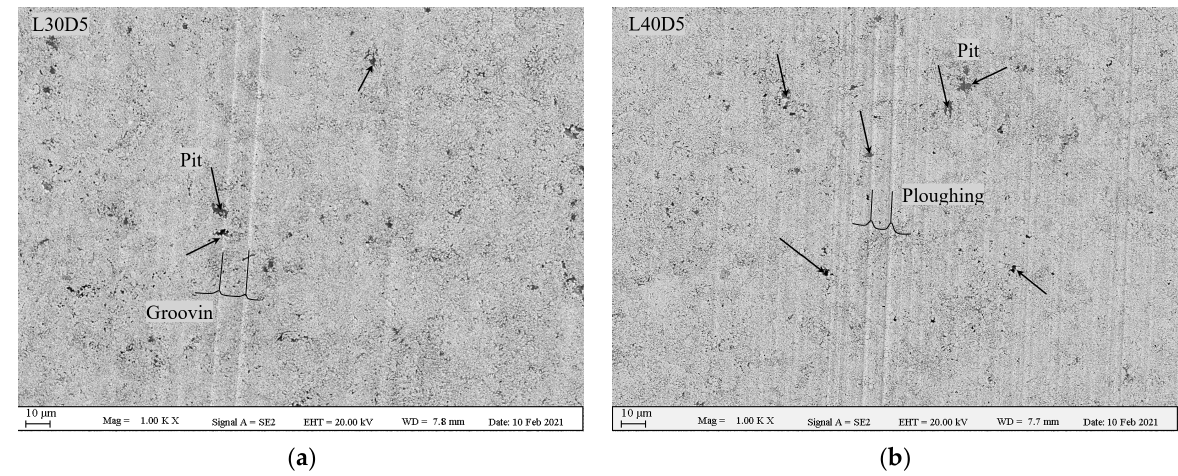
Figure 9. SEM images of wear tracks at different normal loads of 30 N and 40 N. ( a ) L30D5 and ( b ) L40D5